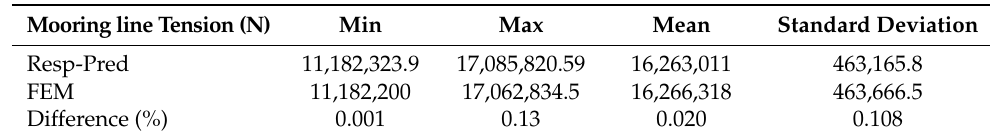
Table 6. FEM and ANN results for statistical mooring line top tension response for wave height of 12.65 m and time of 11.39 s.